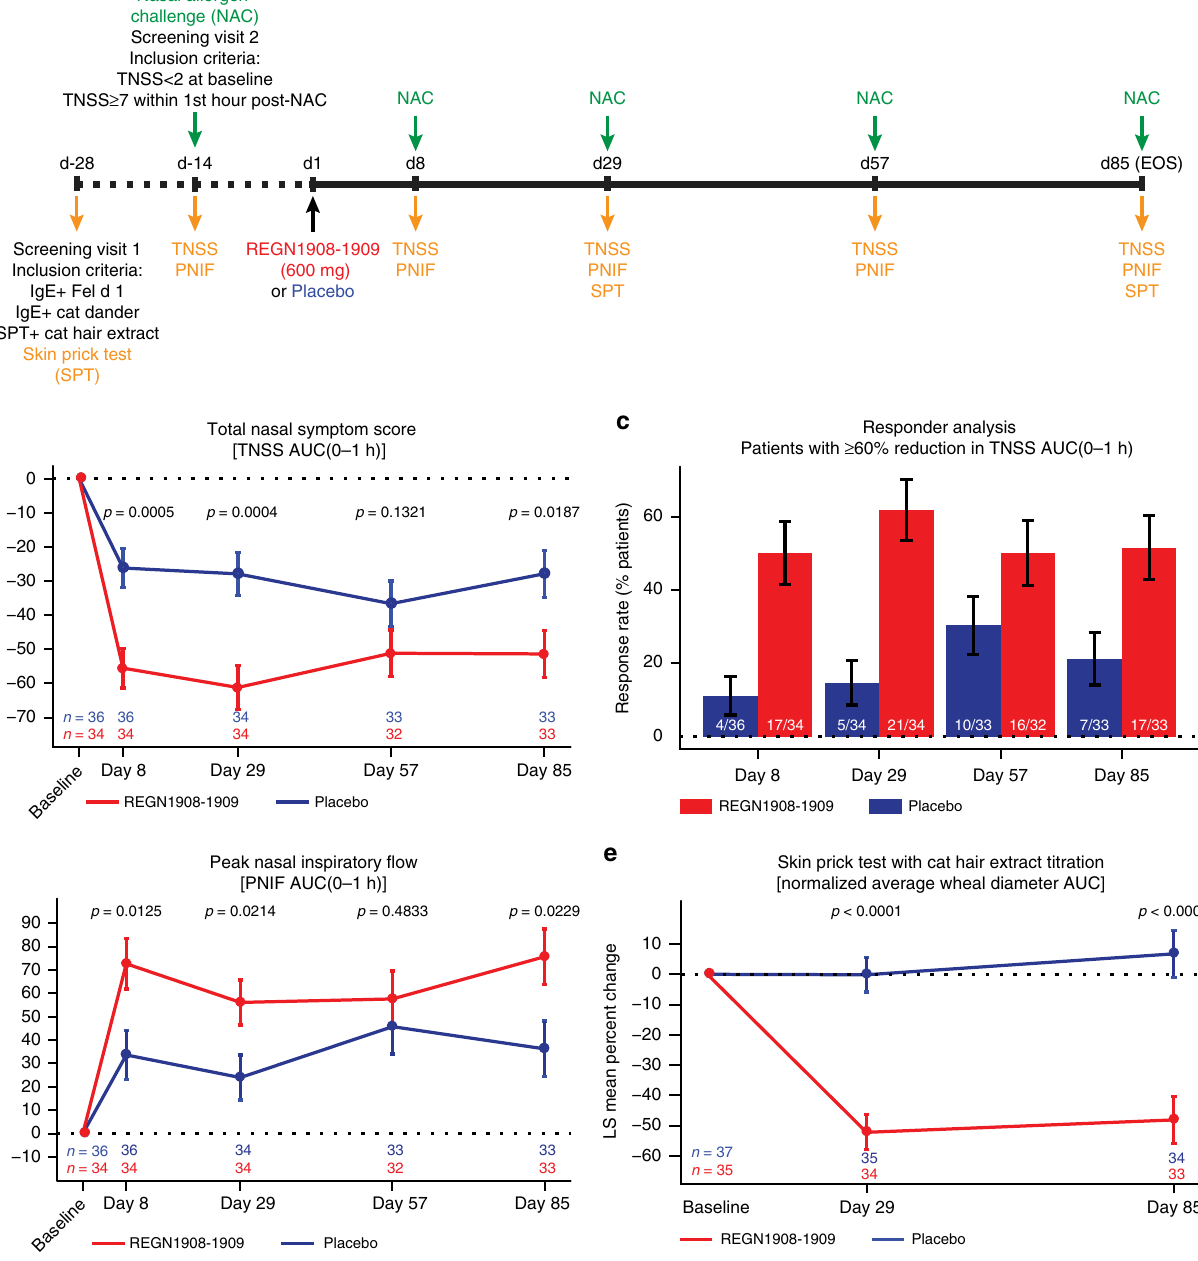
Fig. 5 REGN1908 – 1909 blocks the early phase allergic response to cat extract in patients with cat allergy. a Schematic of the study design. b Percent change from baseline in total nasal symptom score (TNSS) AUC(0 – 1 h); LS mean ± SE is shown for the full analysis set (FAS). c Percentage of patients with ≥ 60% reduction in TNSS AUC(0 – 1 h) is shown at each study timepoint. Numbers on the bars indicate the number of patients represented out of the patient number measured at each timepoint. Percentage of patients ± SE is shown for the FAS. d Percent change from baseline in peak nasal inspiratory fl ow (PNIF) AUC(0 – 1 h); LS mean ± SE is shown for the FAS. e Percent change from baseline in normalized average wheal diameter AUC is shown from